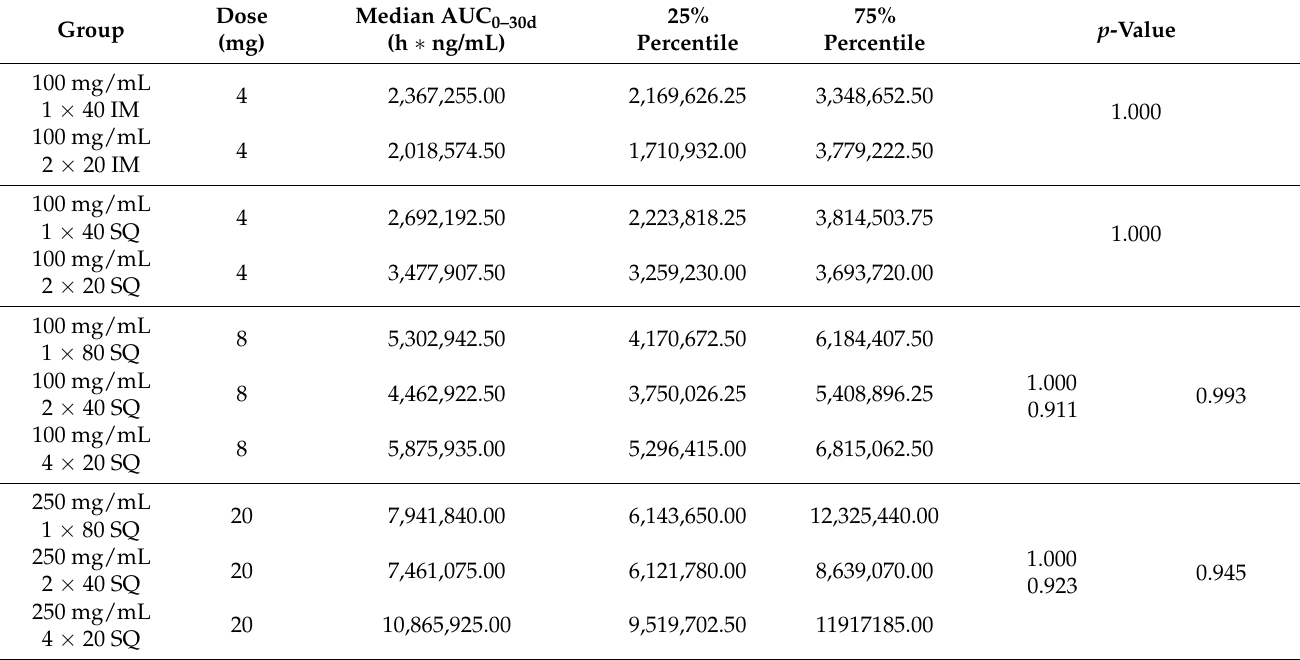
Table 1. Pharmacokinetic Non-compartmental